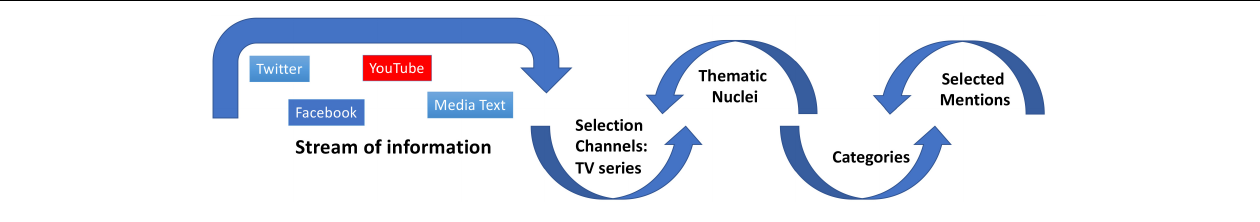
FIGURE 1 | Analysis